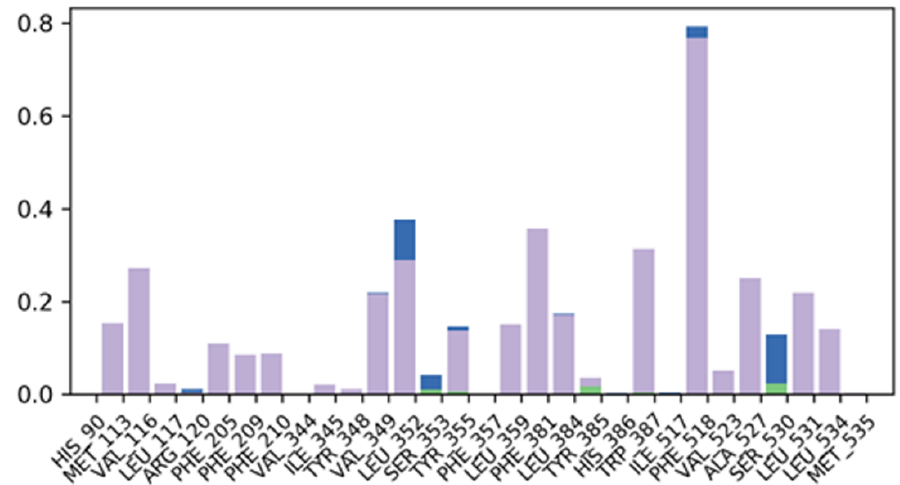
Figure 5. Protein–ligand contacts and detailed protein–ligand interactions were found during the 100 ns MD simulation timescale. H-bonds in green, hydrophobic interactions in slate, and water bridges in blue.